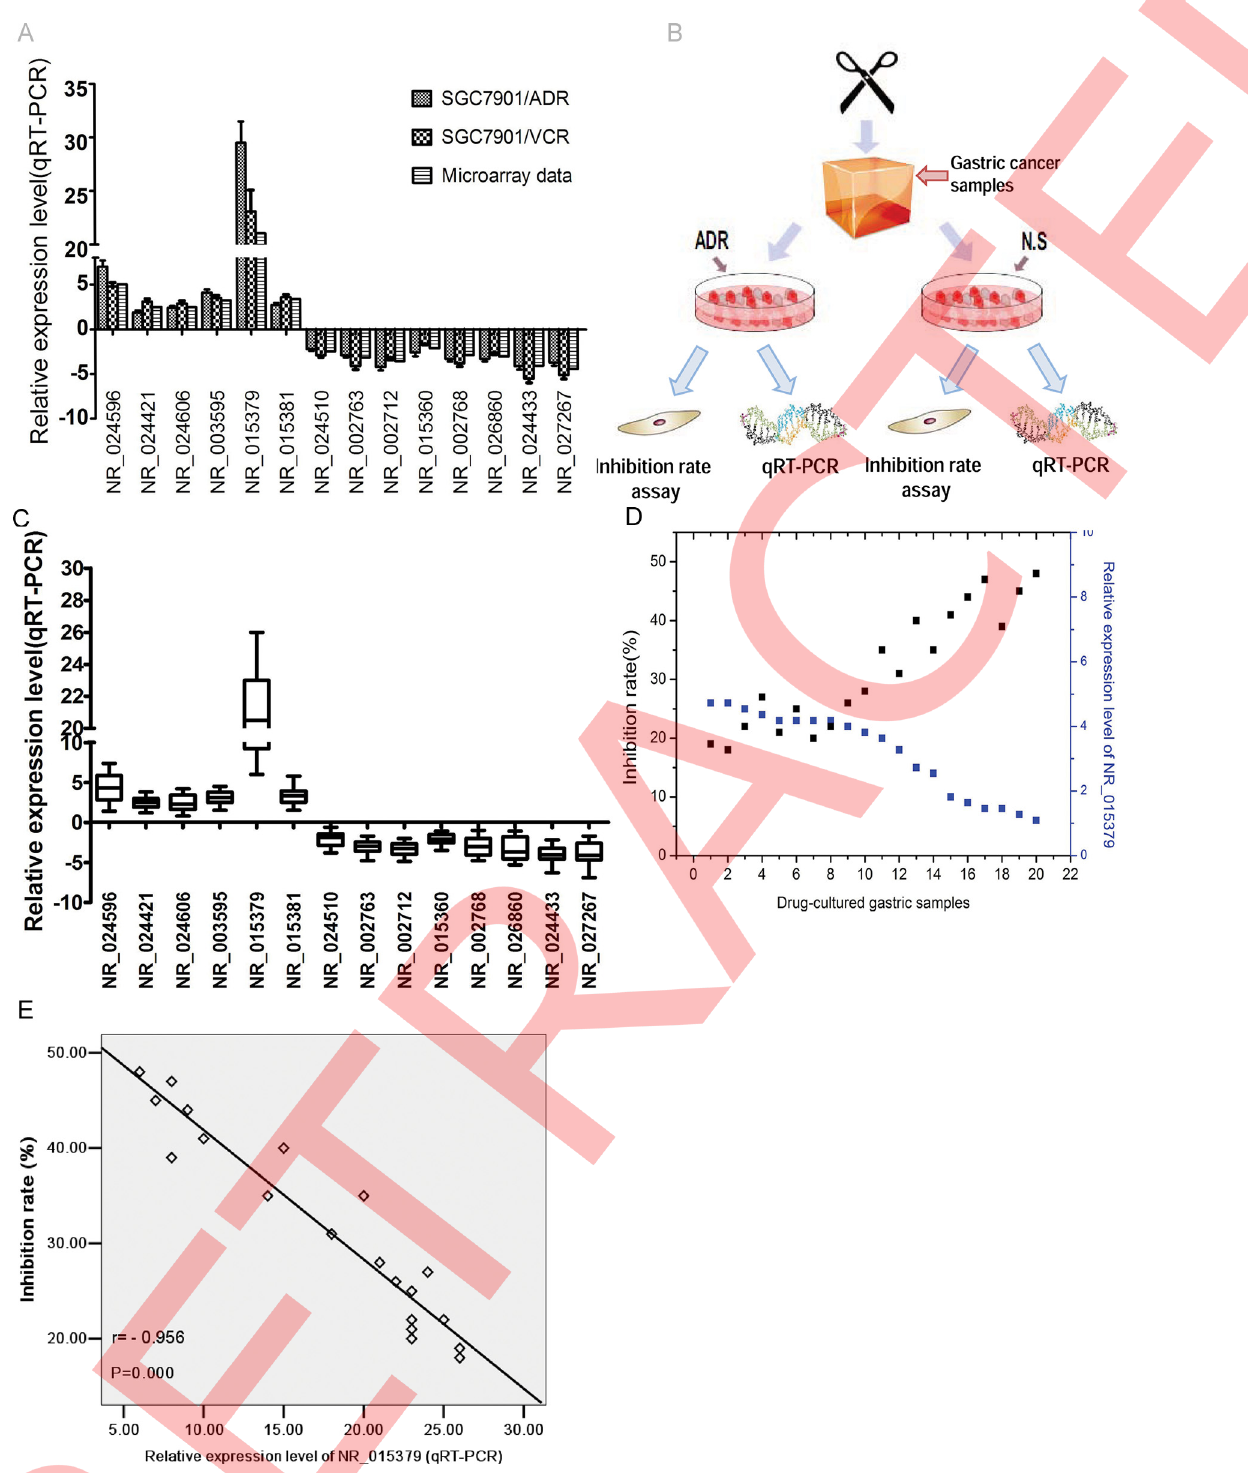
Fig 6. LncRNA chosen randomly for examination using qRT-PCR assay. (A) Sixteen lncRNAs expression levels in SGC7901/ADR and SGC7901/VCR celllines compared with SGC7901 celline. (B) Schematic diagram of gastric cancer samples treated with HDRA followed by qRT-PCR and inhibition rate assay.(C) Sixteen lncRNAs expression levels in twenty gastric cancer samples treated with ADR compared with control groups.(D-E) lncRNA NR_015379 expression levels were negatively correlated with the inhibition rates of gastric cancer samples treated with ADR.